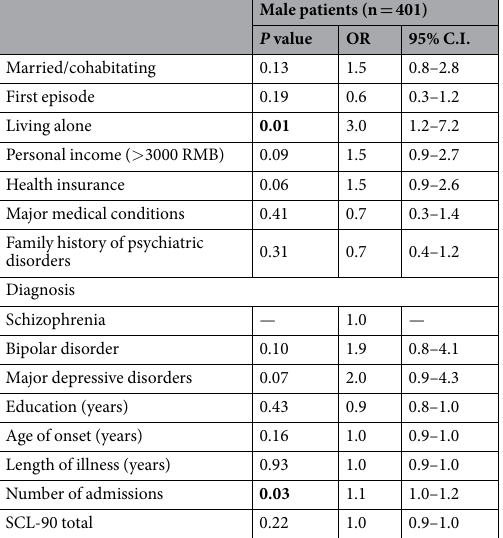
Table 4. Comparisons of demographic and clinical characteristics between smoking and non-smoking in male patients. Bolded values: < 0.05; SCL-90 = Symptom Checklist-90; OR = Odds ratio; Due to collinearity between age and age of onset and length of illness, age was not entered as independent variable in the above multiple logistic regression